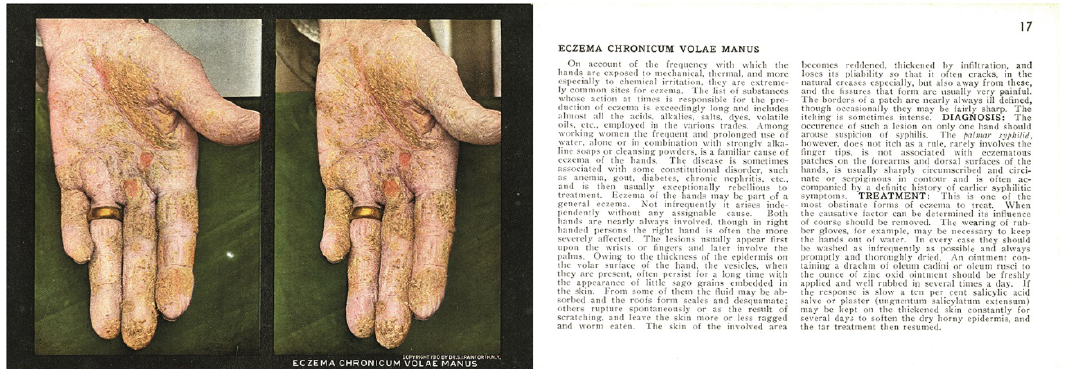
Figure 2 Front and back of the stereoscope card labeled “Eczema Chronicum Volae Manus” from The Stereoscopic Skin Clinic published by Dr. [Seldon Irwin] Rainforth in